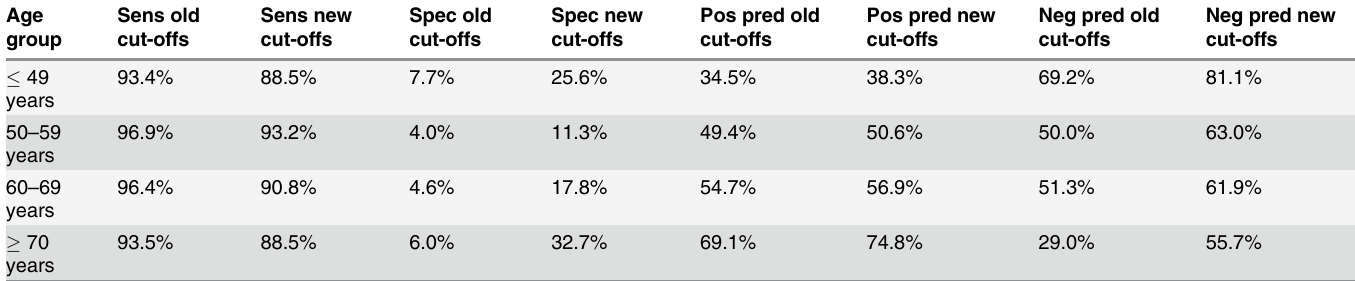
Table 4. Comparison of “ new ” and “ old ” PSA cut offs concerning specificity (spec), sensitivity (sens) as well as positive (pos pred) and negative predictive (neg pred) values stratified by age.